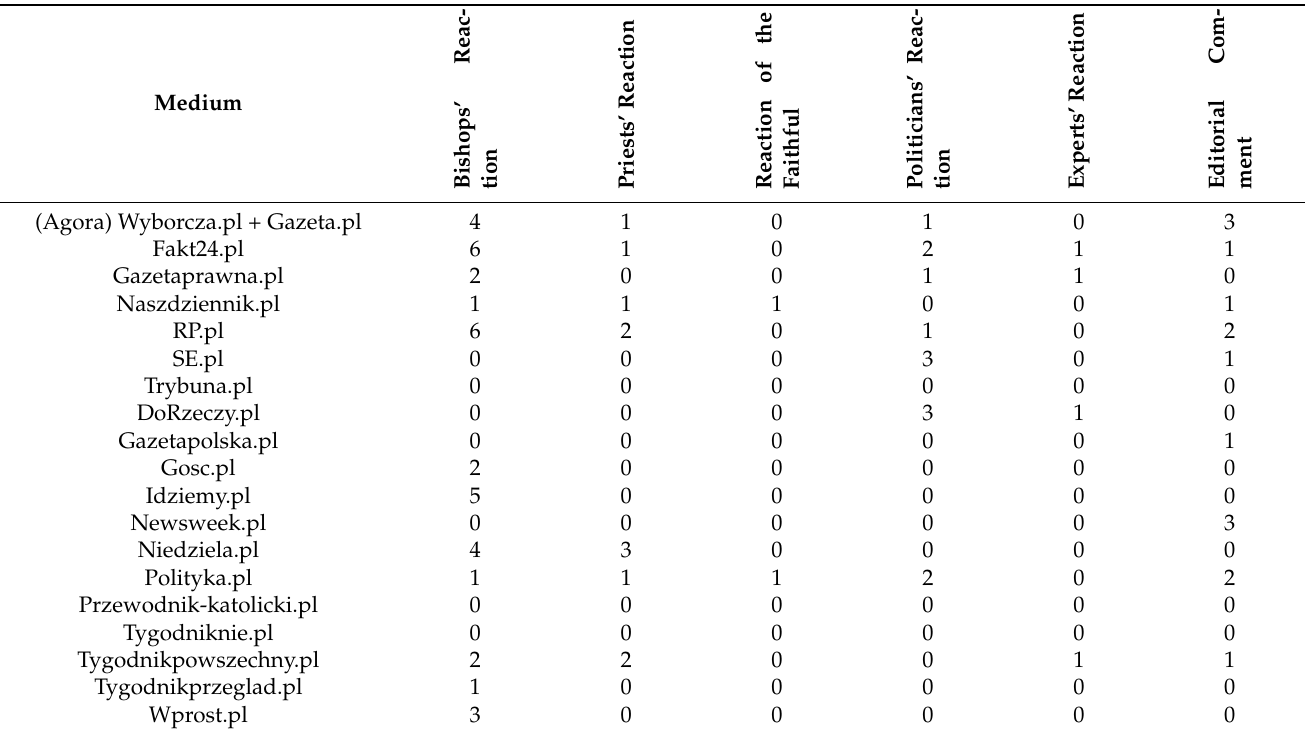
Table 9. Reactions to the dispensation/broadcasts (the numbers do not add up, as one text could have several contexts).